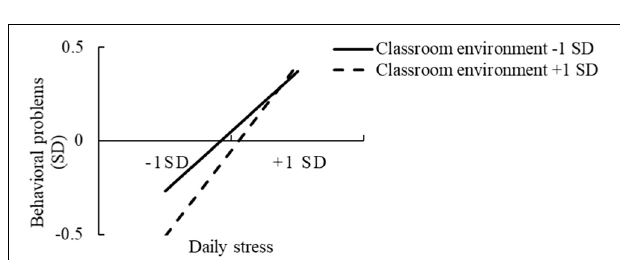
FIGURE 4 | Interaction between daily stress and classroom environment, predicting children’s behavioral